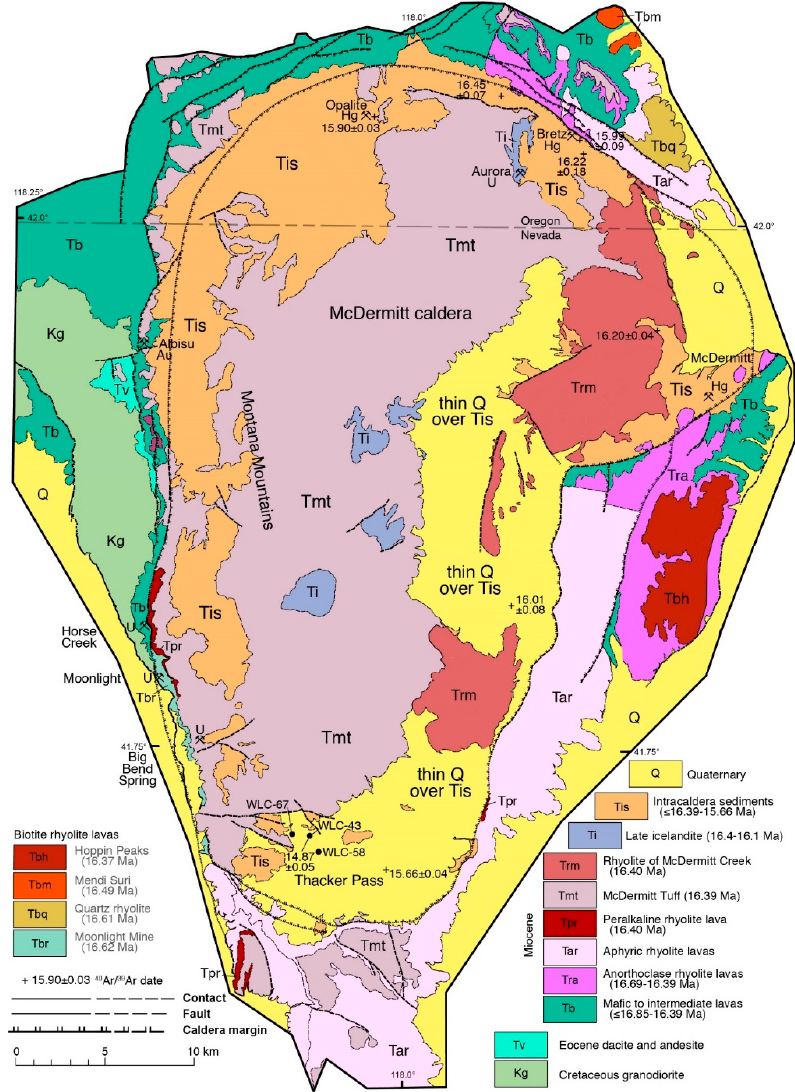
Figure 2. Simplified geologic map of the McDermitt caldera (Simplified from Reference [19]).